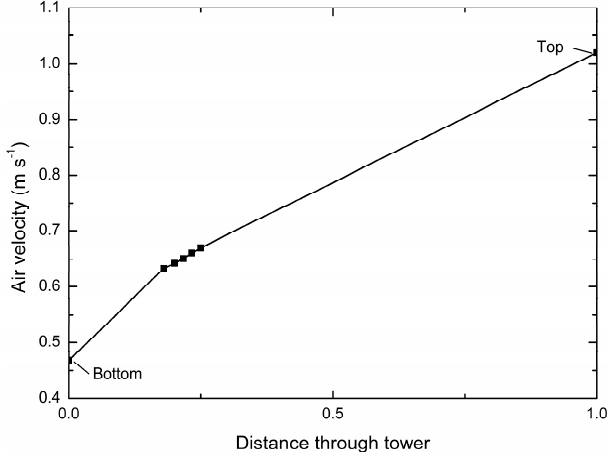
Figure A2. The air velocity through the overall length of the cooling tower.